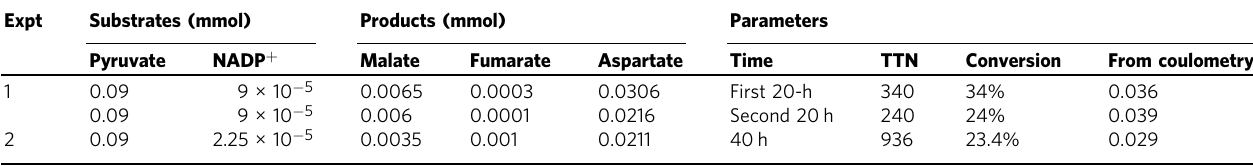
Current traces are shown in Supplementary Fig. S4 (experiment 1) and Supplementary Fig. S6 (experiment 2). Volume in all cases = 4.5 mL.